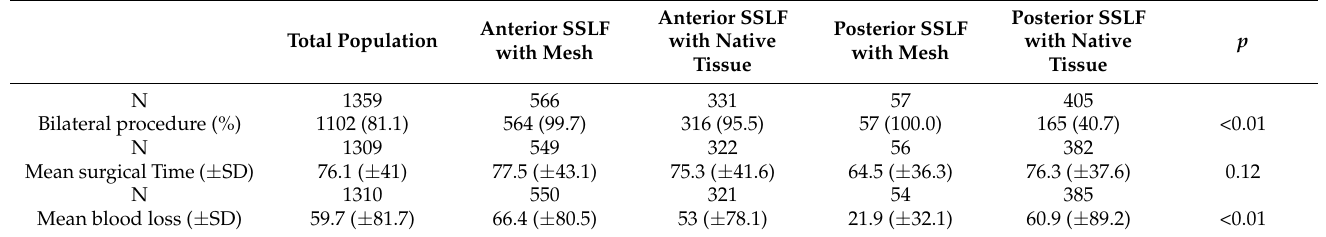
Table 2. Blood loss and surgical time between groups.